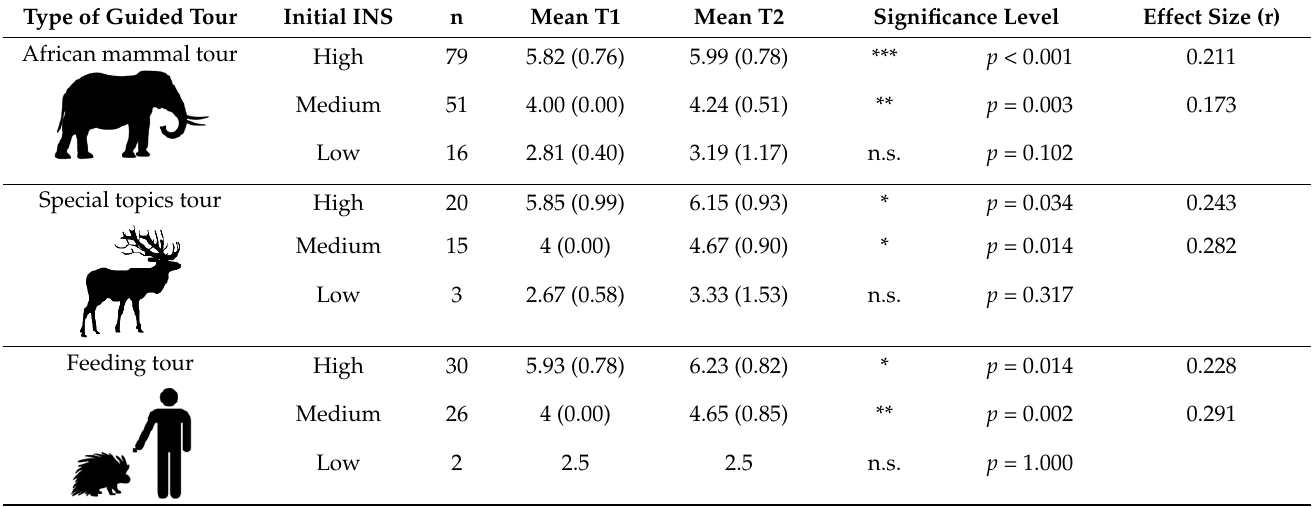
Table A1. Results of the Wilcoxon test for connection to nature. The n stands for the sample size in the subgroup. The standard deviation is given in brackets. No standard deviation could be determined for the group with only two persons. Significant changes are marked with * p < 0.05, ** p < 0.01, *** p < 0.001.